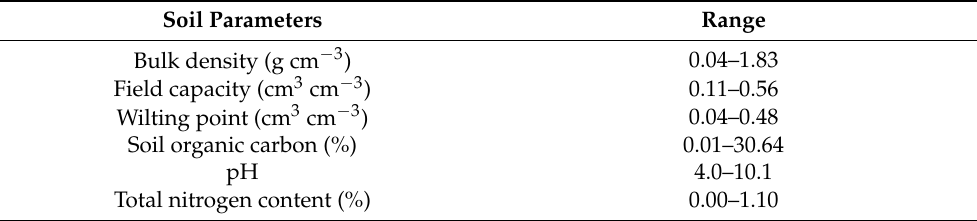
Table 1. Soil parameters in the North China Plain.